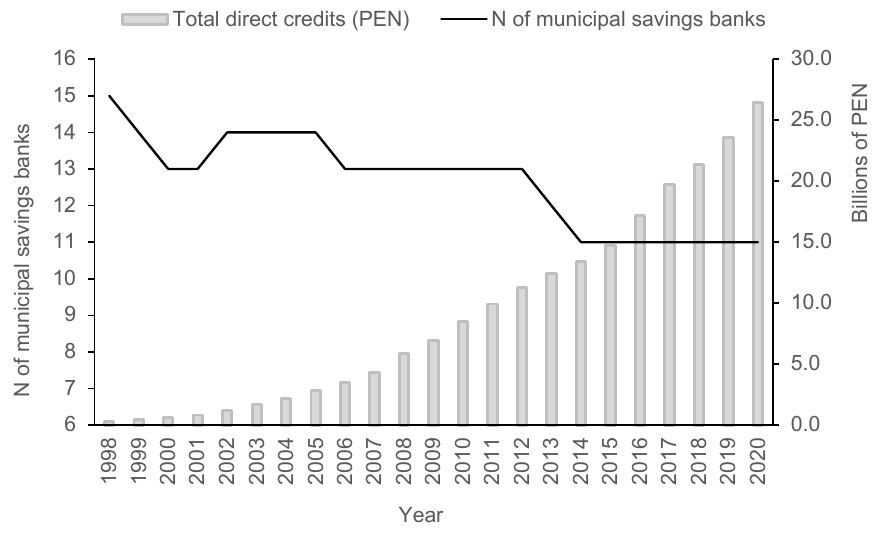
Fig. 1. The number of municipal savings banks in Peru and the number of direct credits (1998-2020). Note: Based on SBS data (2021).